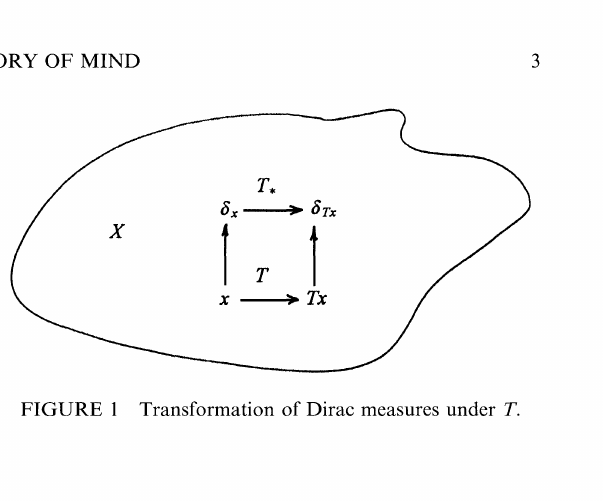
FIGURE Transformation of Dirac measures under